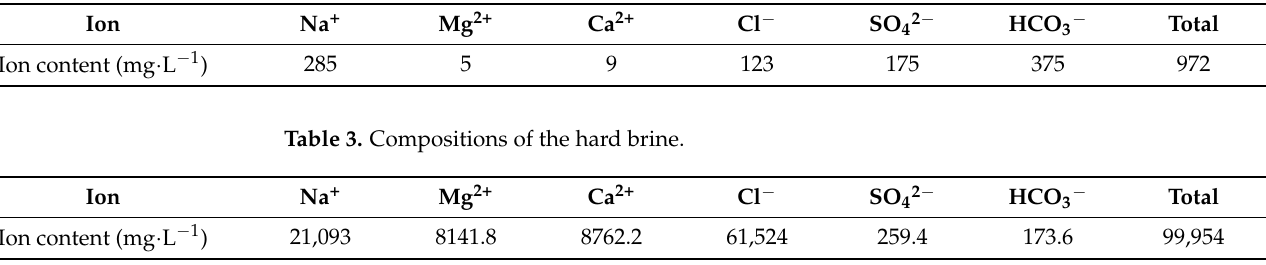
Table 2. Compositions of the soft brine.